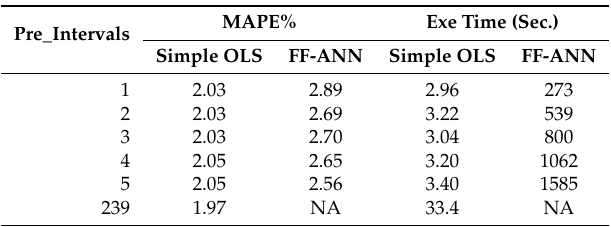
Table 6. Prediction error and computational